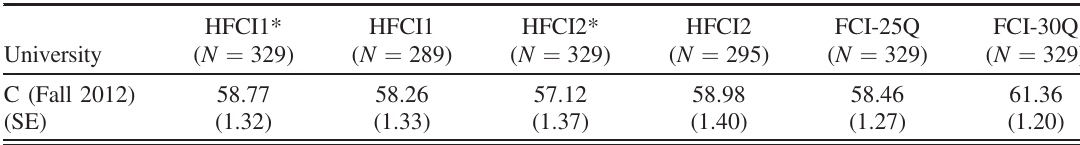
TABLE V. Mean FCI scores at university C broken down into scores on questions appearing on each version of the HFCI, marked with an asterisk (*). Unmarked are the actual test data copied from Table IV. Standard error (SE) and sample size ( N ) are listed for each